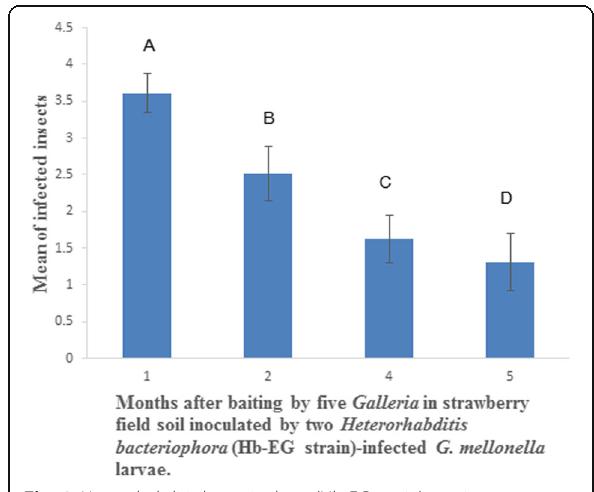
Fig. 2 Heterorhabditis bacteriophora (Hb-EG strain) persistence over 5 months. Means (± SD) of 5 insects/cup (375 insects per 75 root systems; 5 cups per a bed) in 15 strawberry beds. Different letters above bars indicate statistical significance ( P ≤ 0.05) using